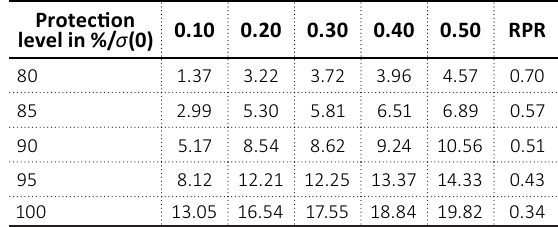
Table 5. American floating-strike lookback option prices with the VolTarget portfolio as an underlying Protection 0.10 level in %/ σ (0)